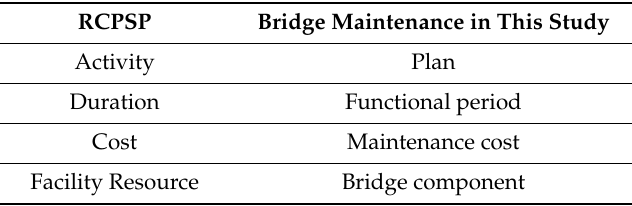
Table 1. Relationship between bridge maintenance and resource-constrained project scheduling problem (RCPSP) framework.